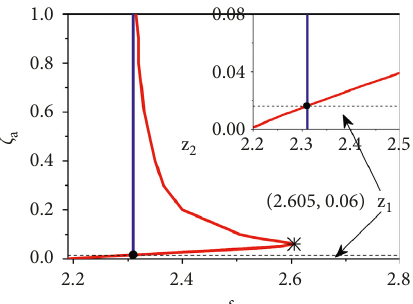
Figure 17: The effect of the damping ratio of the DVA on the instability threshold of the rotor/seal system as σ a